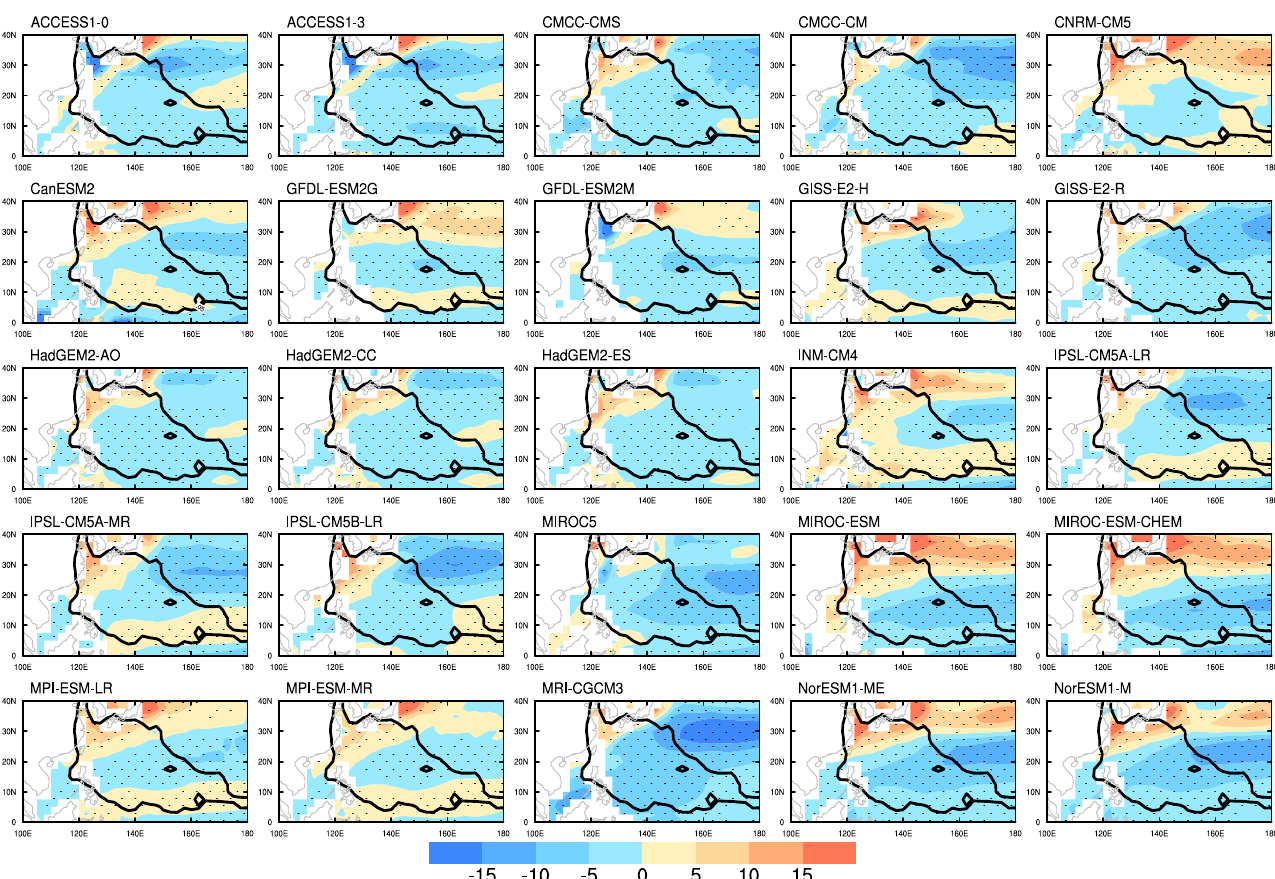
Figure 3. Biases of each CMIP5 model’s PI from observation (indicated by model name). The unit is m s − 1 . Dots represent the fact that the biases are statistically significant at the 95% confidence levels. Meanwhile, the black contour indicates the area where TCs affecting South Korea passed at least once on